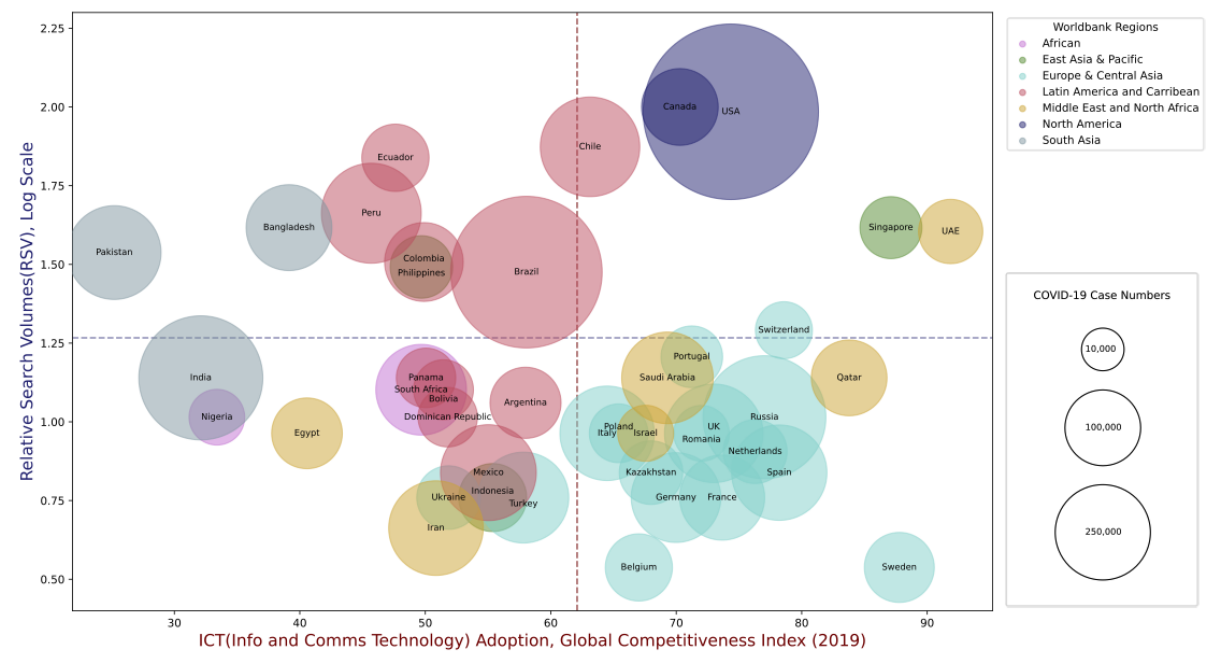
Figure 4. Relationship between telehealth-related relative search volumes (RSVs) versus information and communications technology (ICT) adoption index across the 50 countries most affected by COVID-19. Each country is represented as a data point and color-coded according to its World Bank region. The size of each plot reflects the accumulated total COVID-19 case numbers (as of July 7, 2020). The x axis represents the ICT adoption index, while the y axis represents the scaled (log) RSVs for each country. Vertical and horizontal dashed lines represent the mean values for the x and y axes, respectively. China and countries where RSV=0 (Google Trends) were not included in the